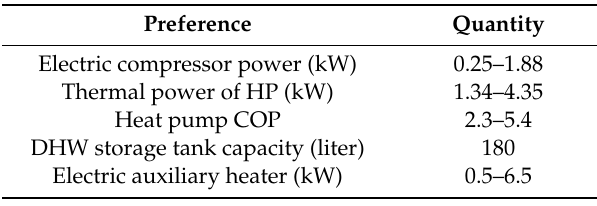
Table 1. Key figures for the compact exhaust air heat pump system. The range of values is for minimum and maximum compressor speeds for inlet air flow rate of 52 l/s at 20 °C and condenser flow rate of 0.2 l/s at 40 °C.